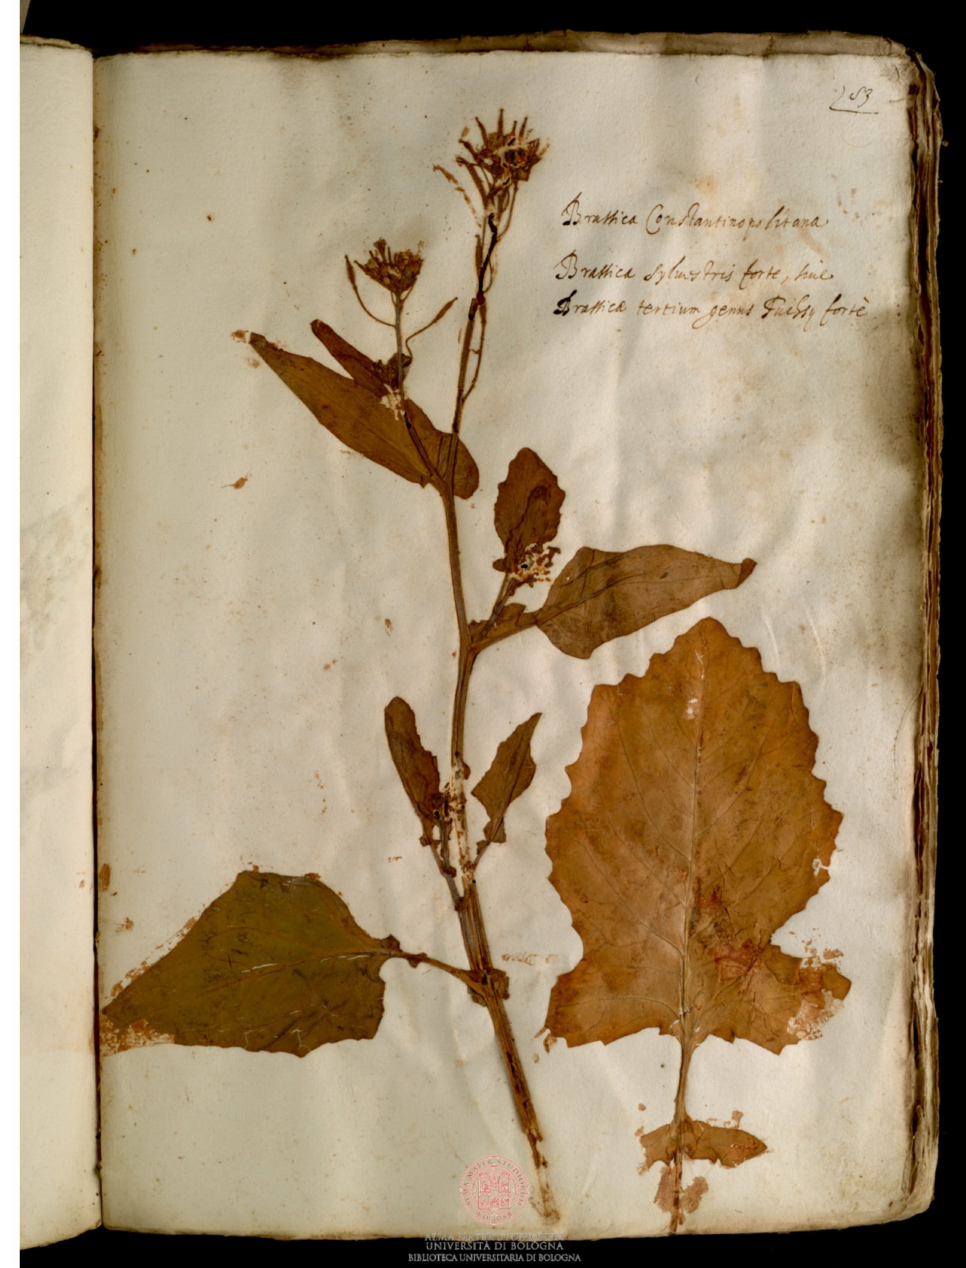
Figure 3. Specimen of Brassica rapa L. preserved in Erbario Aldrovandi, vol. V, c. 83r.; on the sheet, “Brassica Constantinopolitana, Brassica syluestris forte, siue Brassica tertium genus Fuchsij forte” is written. COPYRIGHT © Universit à di Bologna/Sistema Museale di Ateneo—Erbario e Orto